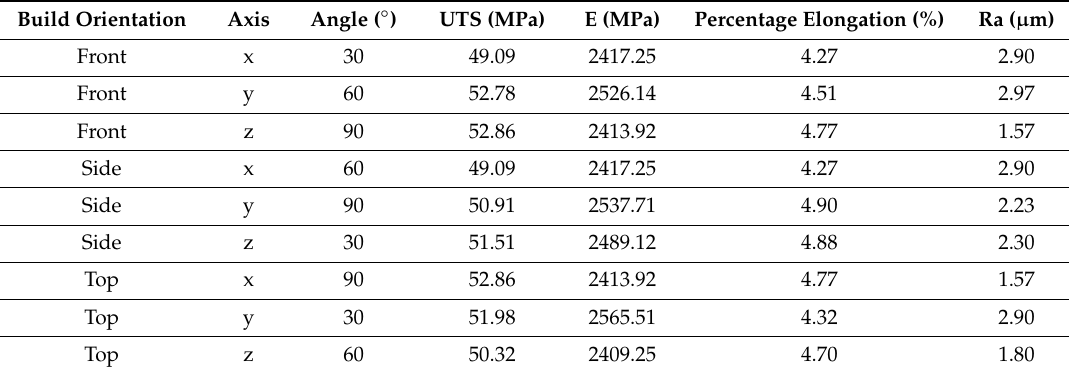
Table 3. Taguchi orthogonal array setup.